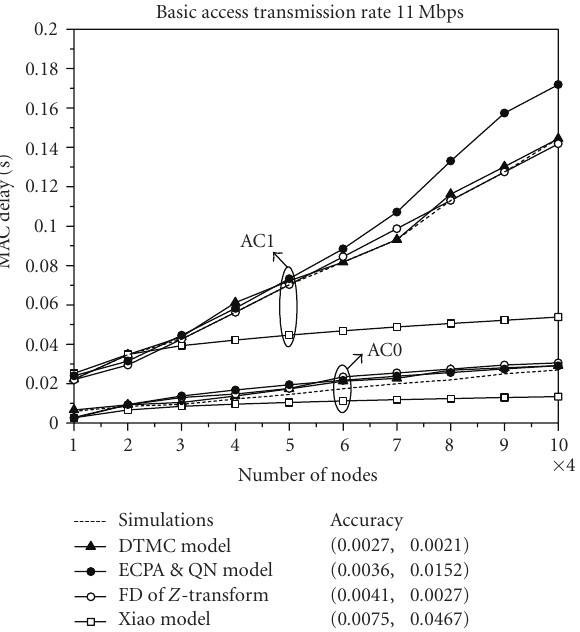
Figure 8: Analysis of MAC delay of the two higher ACs under satu- ration condition and basic access mode.